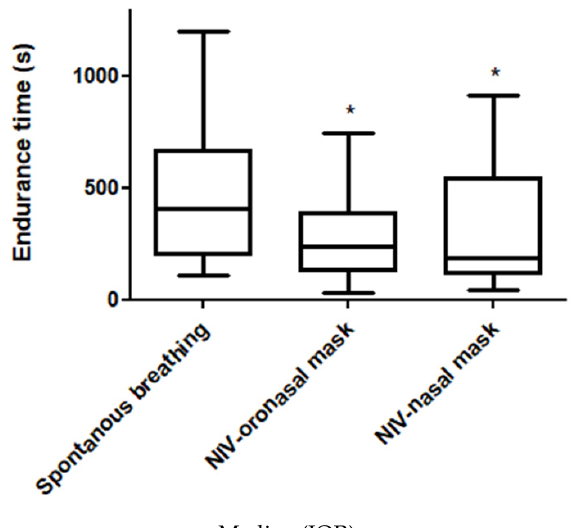
Figure 2. Endurance time for each condition. NIV: noninvasive ventilation. *: significantly lower than the spontaneous breathing condition, p < 0.02 (Friedman one-way analysis of variance and Wilcoxon post hoc analysis).